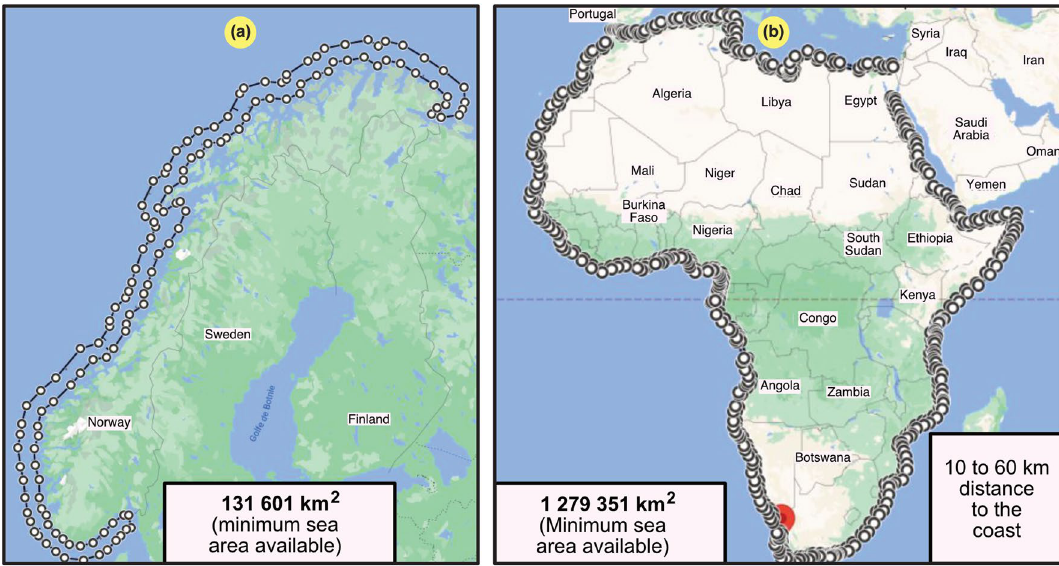
Figure 11. Illustrative examples to estimate the minimum available sea area (conservative case) for offshore wind turbines considering a corridor of just 50 km (more cases are provided in Table 13). They were created with the use of the Google Earth Engine 25 , version 7.3.2.5776 (https:// earth. google. com/ web/). ( a ) Norway. ( b )